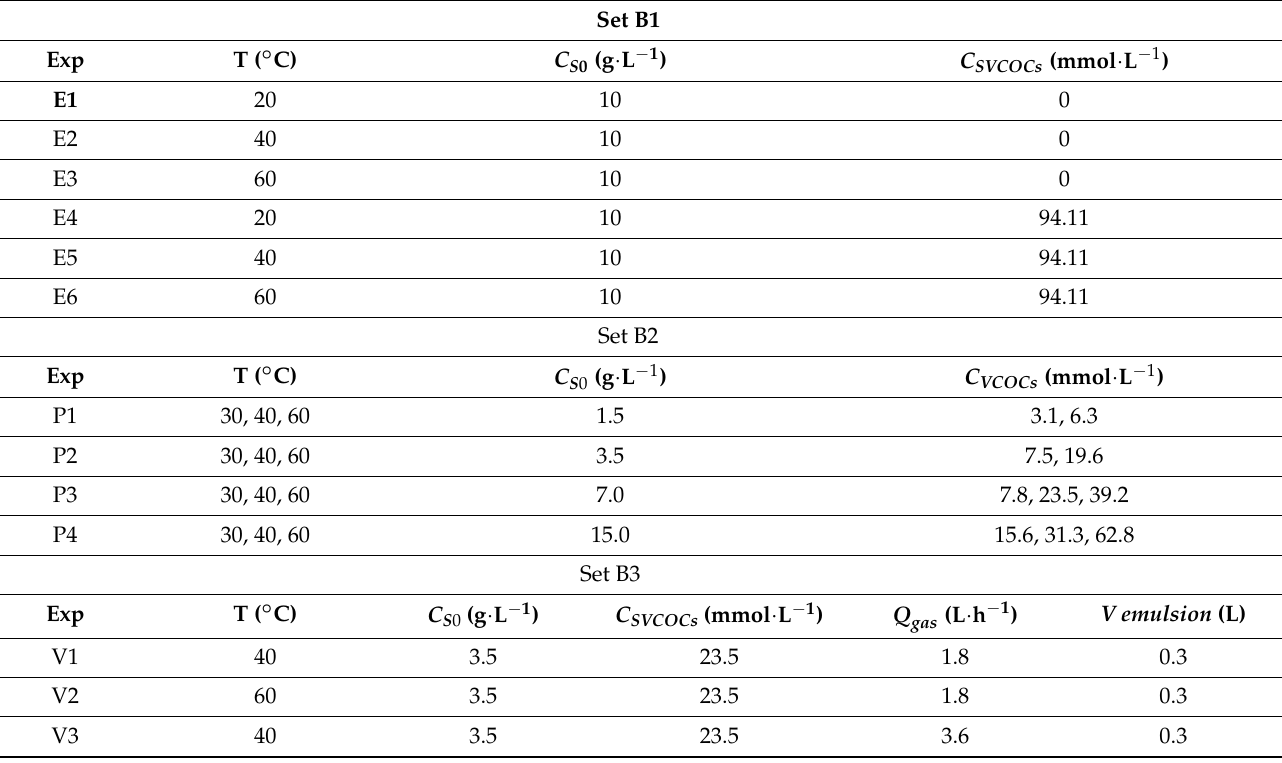
Table 1. Experimental conditions for the experimental set. SVCOCs distribution (as molar percentage) was 53% of CB, 29% of 1,2-DCB, and 18% of